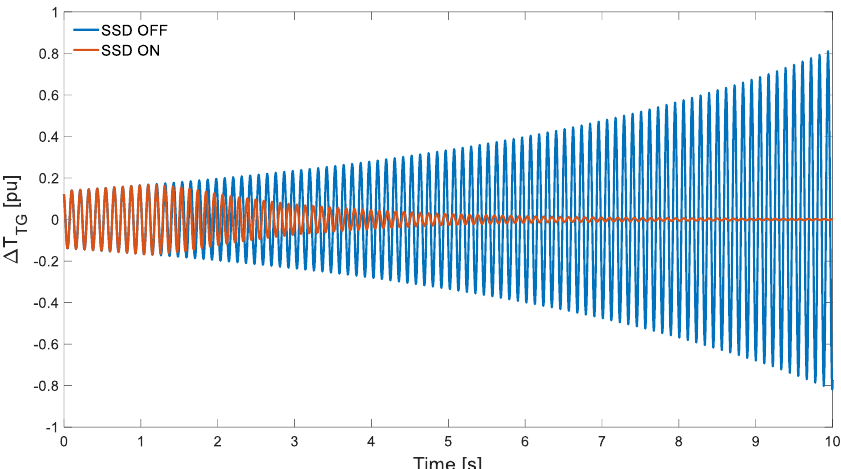
Figure 11. Torque oscillation ∆ T TG at the first TNF in configuration CA (results related to the data of Table 4).